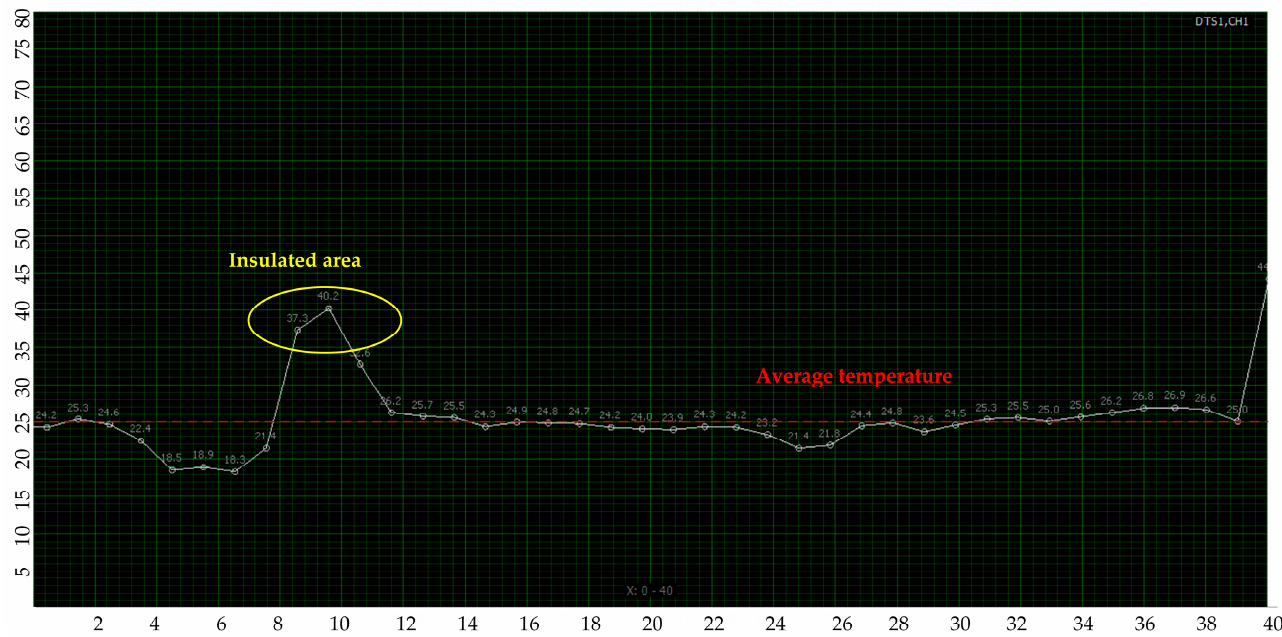
Figure 8. Temperature anomaly detection image.